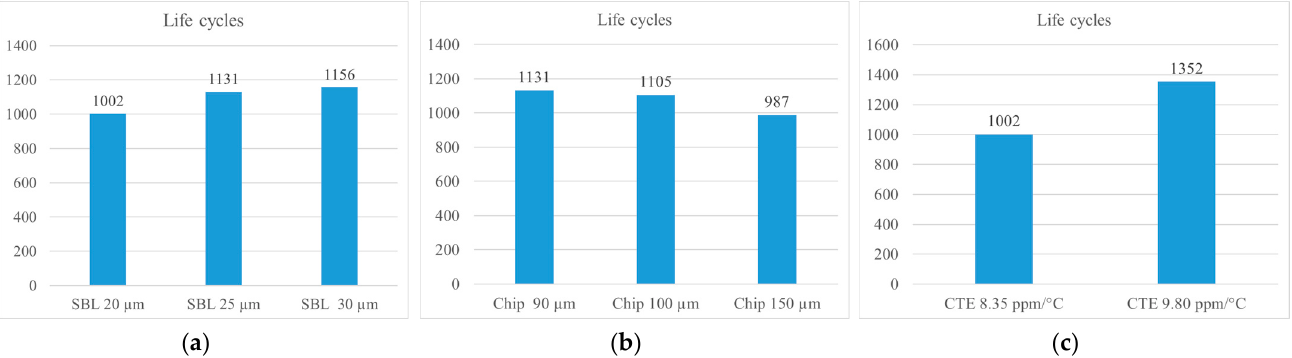
Figure 18. Life predictions of the FO ‐ WLP PoP under different ( a ) SBL thicknesses, ( b ) chip thicknesses, and ( c ) CTEs. Table 4. Combination of the design parameters in the parametric analysis of the FO ‐ WLP PoP.